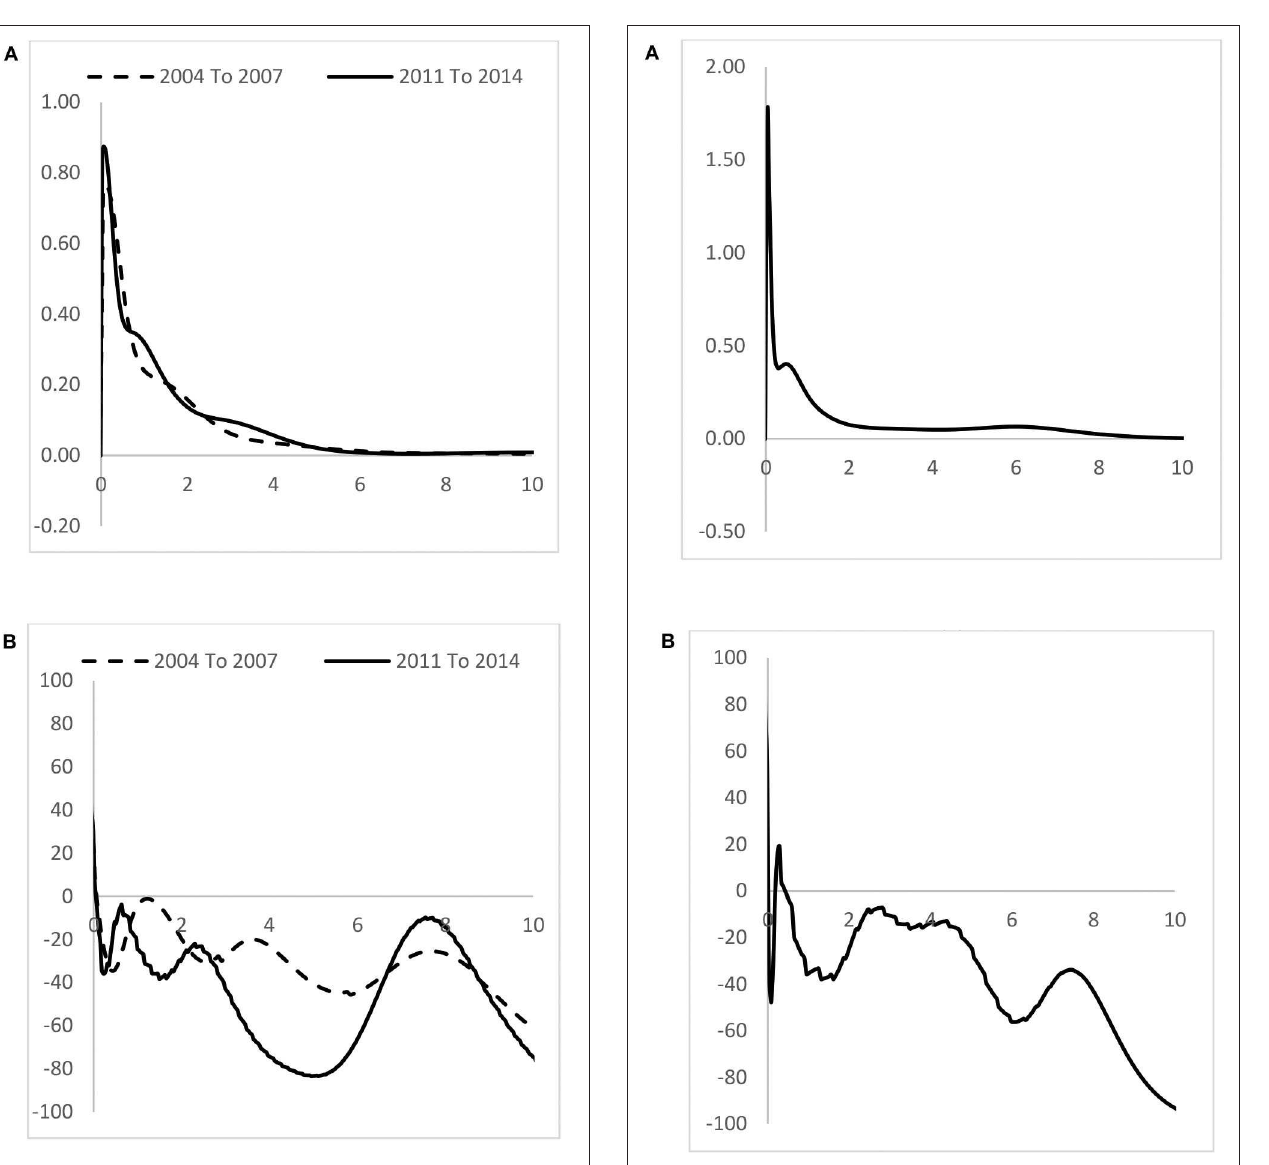
FIGURE 7 | Ergodic distribution and MPP of the gas market for all countries. Note: For (A) , horizontal axis represents relative per capita consumption, vertical axis represents proportion. For (B) , horizontal axis represents relative per capita consumption, vertical axis represents MPP. Source: Authors’